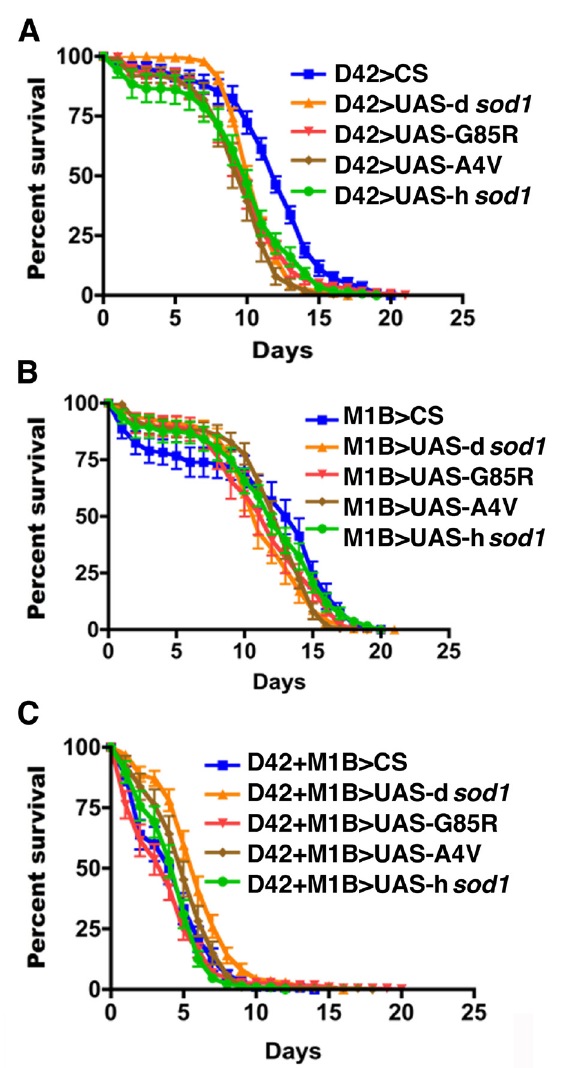
Figure S4. Effects of paraquat on SOD1 transgenic flies. Five day-old male flies expressing SOD1 proteins in motor neurons ( A ), glial cells ( B ) and in motoneurons together with glial cells ( C ) were treated with 20 mM paraquat in fly food (10 flies per vial). The results do not indicate any significant effect of paraquat in SOD1 flies of all genotypes. Total flies uses for D42Gal4>CS, 183; D42Gal4>UAS- dsod1 , 194; D42Gal4>UAS-hSOD1 A4V , 138; D42Gal4>UAS-hSOD1 G85R